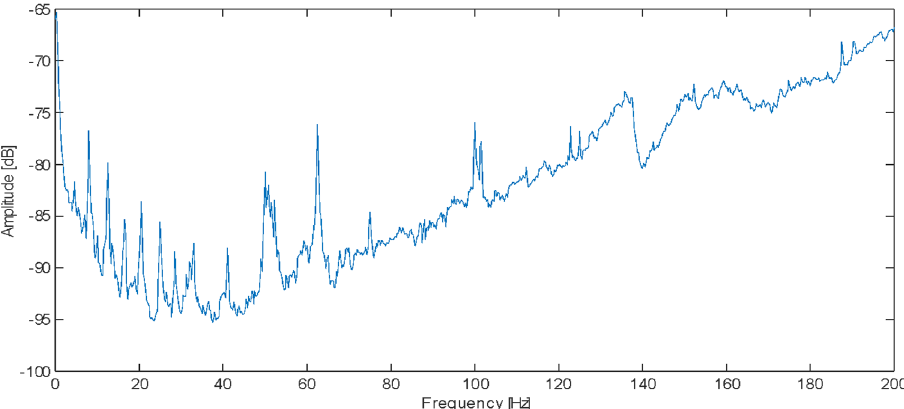
Figure 12. SUM indicator from FRF for EMA when stationary.